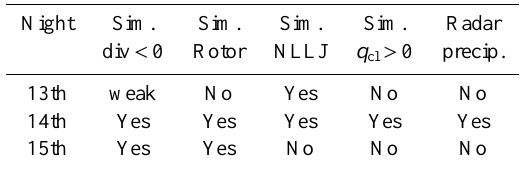
Table 1. Relation between the atmospheric conditions according MM5 simulation and radar observation.